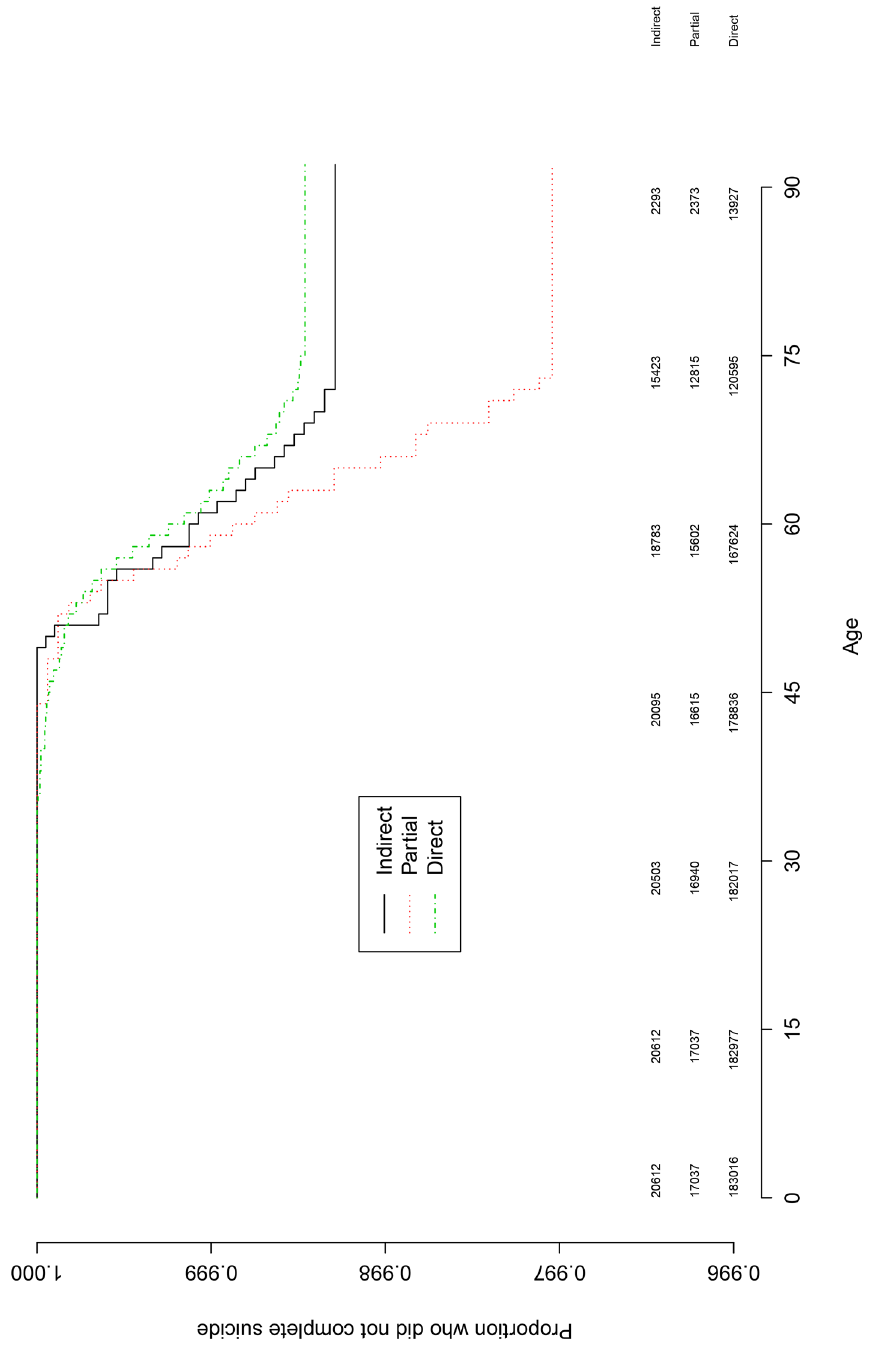
Fig 1. Kaplan-Meier survival curve for the cumulative probability of suicide risk for the indirect, partial and direct exposure groups. Note. The curves depict average age of suicide for the exposure groups based on Kaplan-Meier modeling estimates. The vertical axis is the proportion that did not complete suicide. The numbers under the horizontal axis are age, and the numbers above the x-axis are the numbers at risk every 15